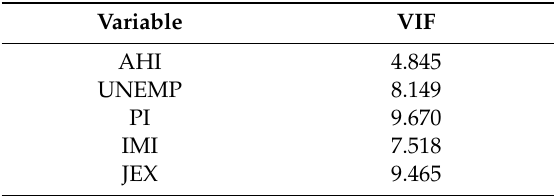
Table 7. Variance Inflation Factor (VIF) for economic and real estate